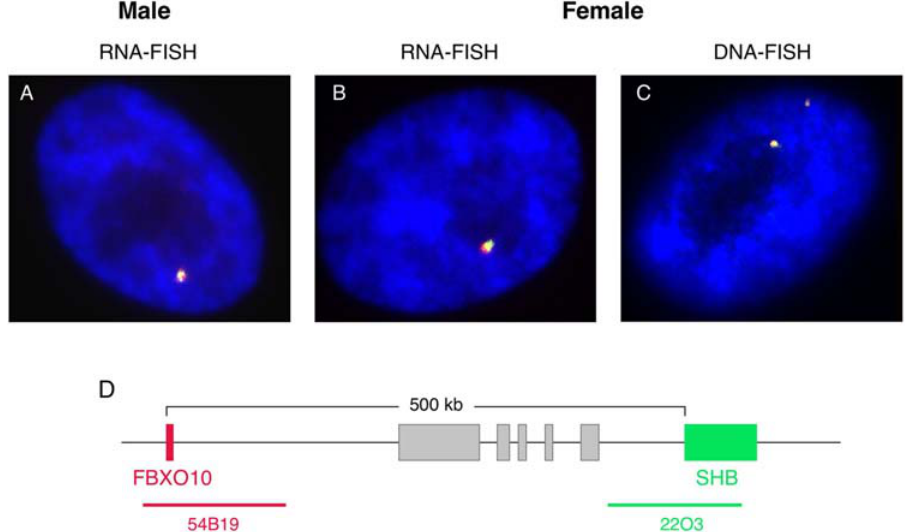
Figure 4. Two-colour RNA-FISH of neighbouring genes FBXO10 (red) and SHB (green). (A) Male nucleus expresses both genes from the single X. (B) Female nucleus expresses both genes from the same single X chromosome. (C) Female DNA-FISH showing that loci are located together. (D) Diagram depicting the region and the location of BACs used for RNA-FISH. Grey boxes indicate genes located between these two BACs.